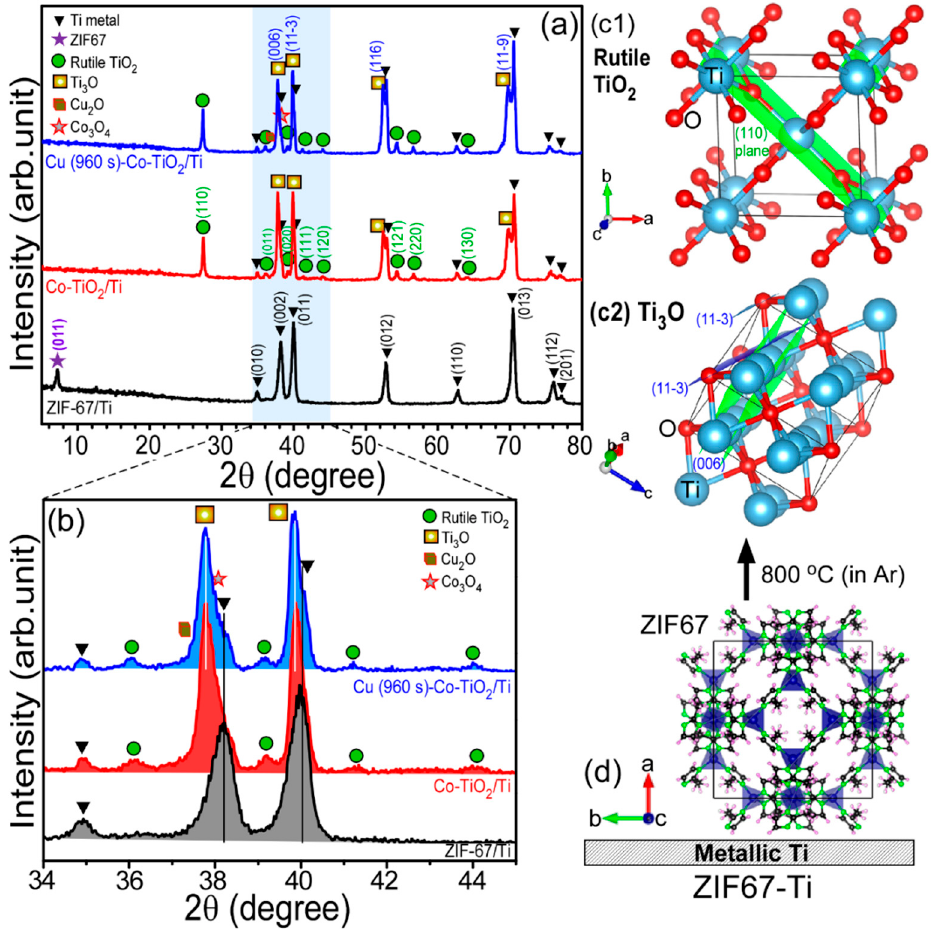
Figure 2. XRD diffraction patterns ( a ) of as-prepared ZIF-67/Ti, Co-TiO 2 /Ti, Cu (960 s)-Co-TiO 2 /Ti samples; expanded XRD regions (34°–45°) ( b ); crystal structure projections of rutile TiO 2 ( c1 ); and Ti 3 O ( c2 ); and a cartoon of ZIF67 loaded on Ti support ( d ).